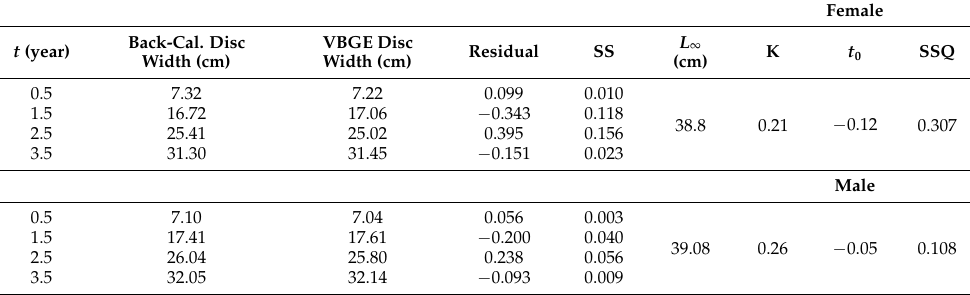
Table 3. von Bertalanffy growth equation (VBGE) results for Okamejei kenojei collected from the West Sea of South Korea (SS: sum of squares of deviation; L ∞ : theoretical maximum disc width; K: growth coefficient; SSQ: sum of squared